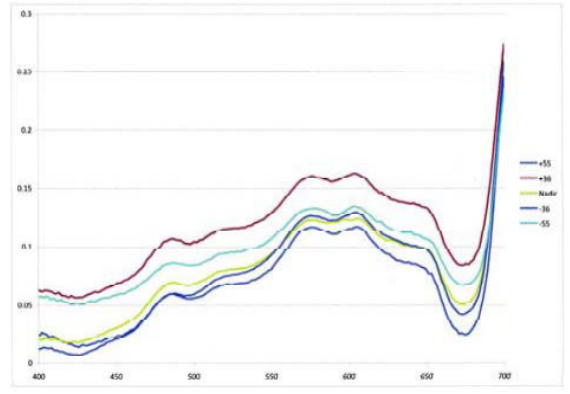
Figure 4: Reflectance of corymbose coral in the solar principal plane for five view angles.